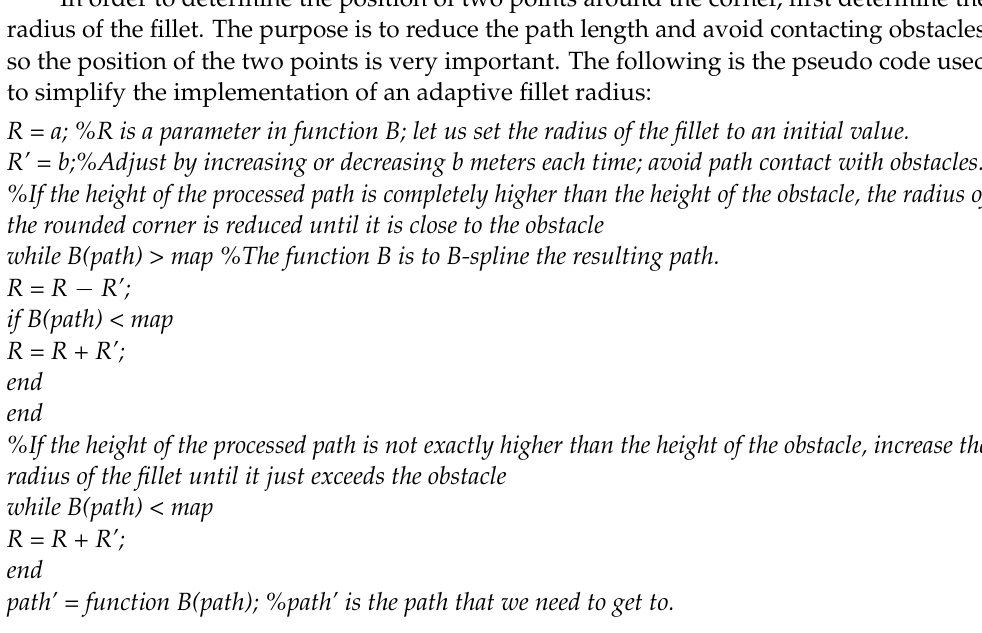
Figure 9. The effect of angle optimization.